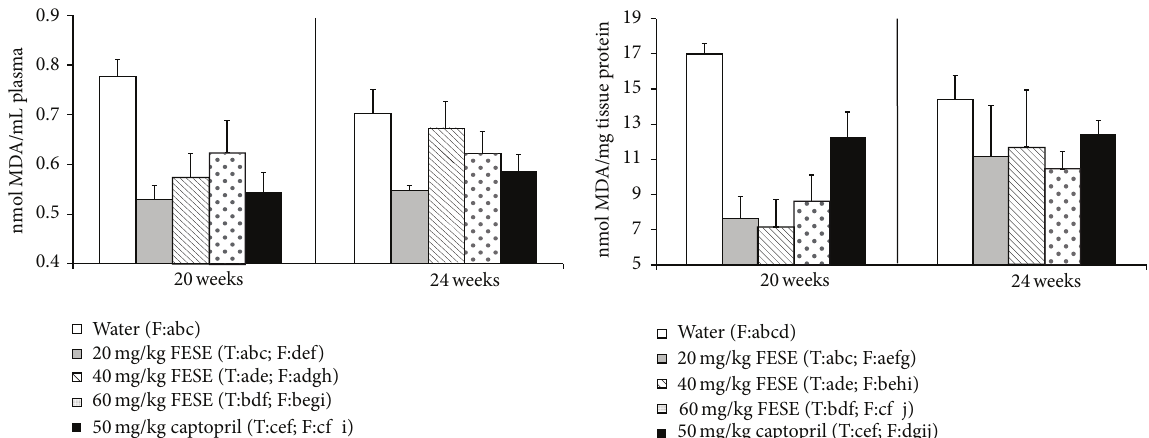
Figure 5: Malondialdehyde (MDA) equivalents in plasma and liver samples from spontaneously hypertensive rats. The animals drank different fluids from weaning until the 20th week of life (treatment period = T) and received therefore different daily treatments: tap water, 20 mg/kg/day Fraxinus excelsior L. seed extract (FESE), 40 mg/kg/day FESE, 60mg/kg/day FESE, or 50 mg/kg/day captopril. All rats drank tap water from the 20th week of life until the 24th week of life (follow-up period = F). Data are mean values ± SEM for 10 animals in T and for 5 animals in F. Similar letters represent no statistical differences ( 𝑃 > 0.05 ). 𝑃 estimated by one-way ANOVA.